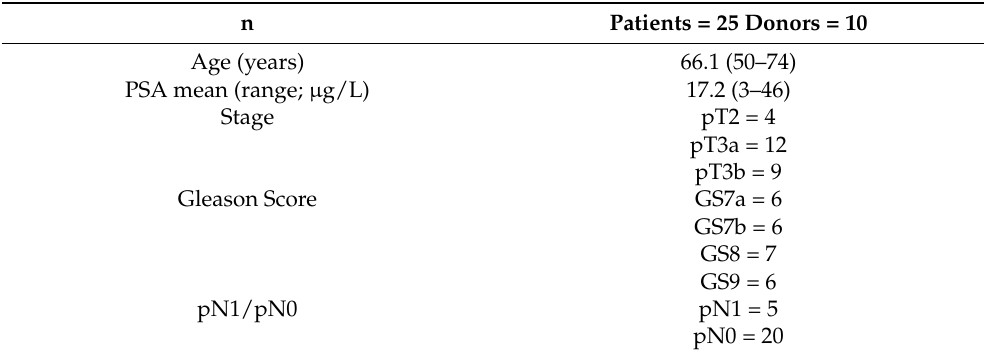
Table 1. Intermediate-to-high-risk patient group. Stages and Gleason scores determined from pathology